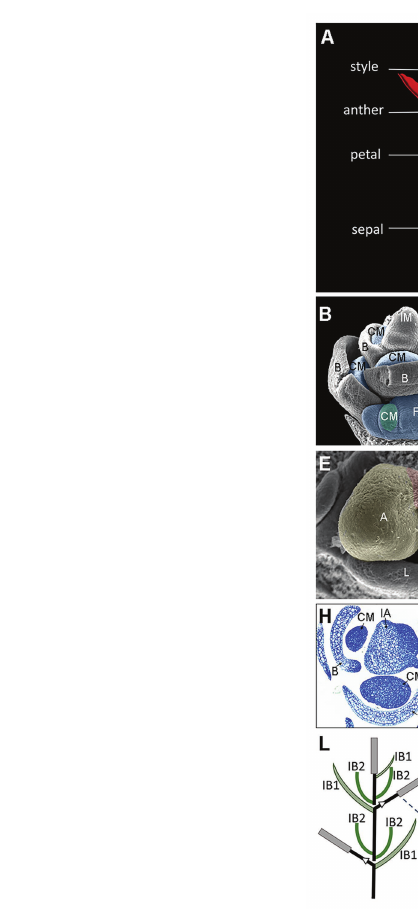
FIGURE 1 | Flower anatomy and ontogeny of Canna indica . (A) Flower dissection showing the floral structure. (B–F) Flower organogenesis observed under a scanning electronic microscopy. (B) Lateral view of a young inflorescence with developing cincinni meristems subtended by the primary bracts. (C) Top view of a cincinni. Three sepal primordia and three petal-stamen common primordia have already formed in the primary flower. (D) Further development of the cincinni. CP1 separates into the first petal and the adaxial stamen, and the later one develops into an anther primordium in the left side and a petaloid appendage primordium in the right side. CP2 separates into the second petal and the labellum primordium. The second floral meristem has formed, and the cincinnus meristem moves to the abaxial side of the secondary flower. (E) Close-up of the asymmetric pattern of the adaxial stamen in the primary flower. The anther primordium is growing quickly while the petaloid appendage slows down its growing. (F) Front view of a fully developed anther. The petaloid appendage continues to develop in a petaloid way together with other petaloid staminodes (PS2 is not shown in this figure). (G) A fertile stamen before mature. (H–K) Transverse semithin sections stained with toluidine blue representing the same developmental stages with (B,D,E,F) , respectively. (L) Illustrated inflorescence and floral diagram. The arrows and shades in blue and orange represent the presumed impact on the primary flower by the main florescence axis and the cincinnus meristem, respectively. A, anther; ab, abaxial; ad, adaxial; an, anodic; AS, aborted staminode; B, primary bract; C, carpel; ca, cathodic; CM, cincinni meristem; CP, petal-stamen common primordium; FM, flower meristem; IA, florescence axis; IB1, the bract enclosing the primary rachis of the inflorescence; IB2, the bract which are placed at the base of the new rachis at each branching point, enclosing the new rachis. IM, inflorescence meristem; L, labellum; P, petal; PA, petaloid appendage; PF, partial florescence; PS, petaloid staminode; S, sepal; SB, secondary bract. Blue shades in (B) indicate partial florescences enclosed by the primary bracts. Green shades in (B–D) indicate cincinnus meristems. Yellow and red shades in (D–F) indicate the anther primordium and the petaloid appendage primordium, respectively. Bars: (A) = 1 cm; (B–K) = 100 μ